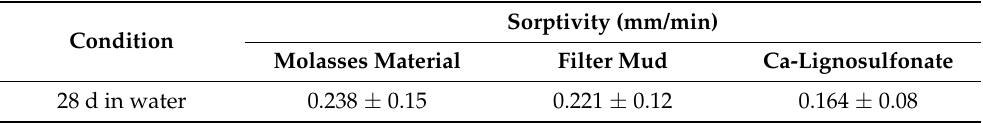
Table 5. Sorptivities of